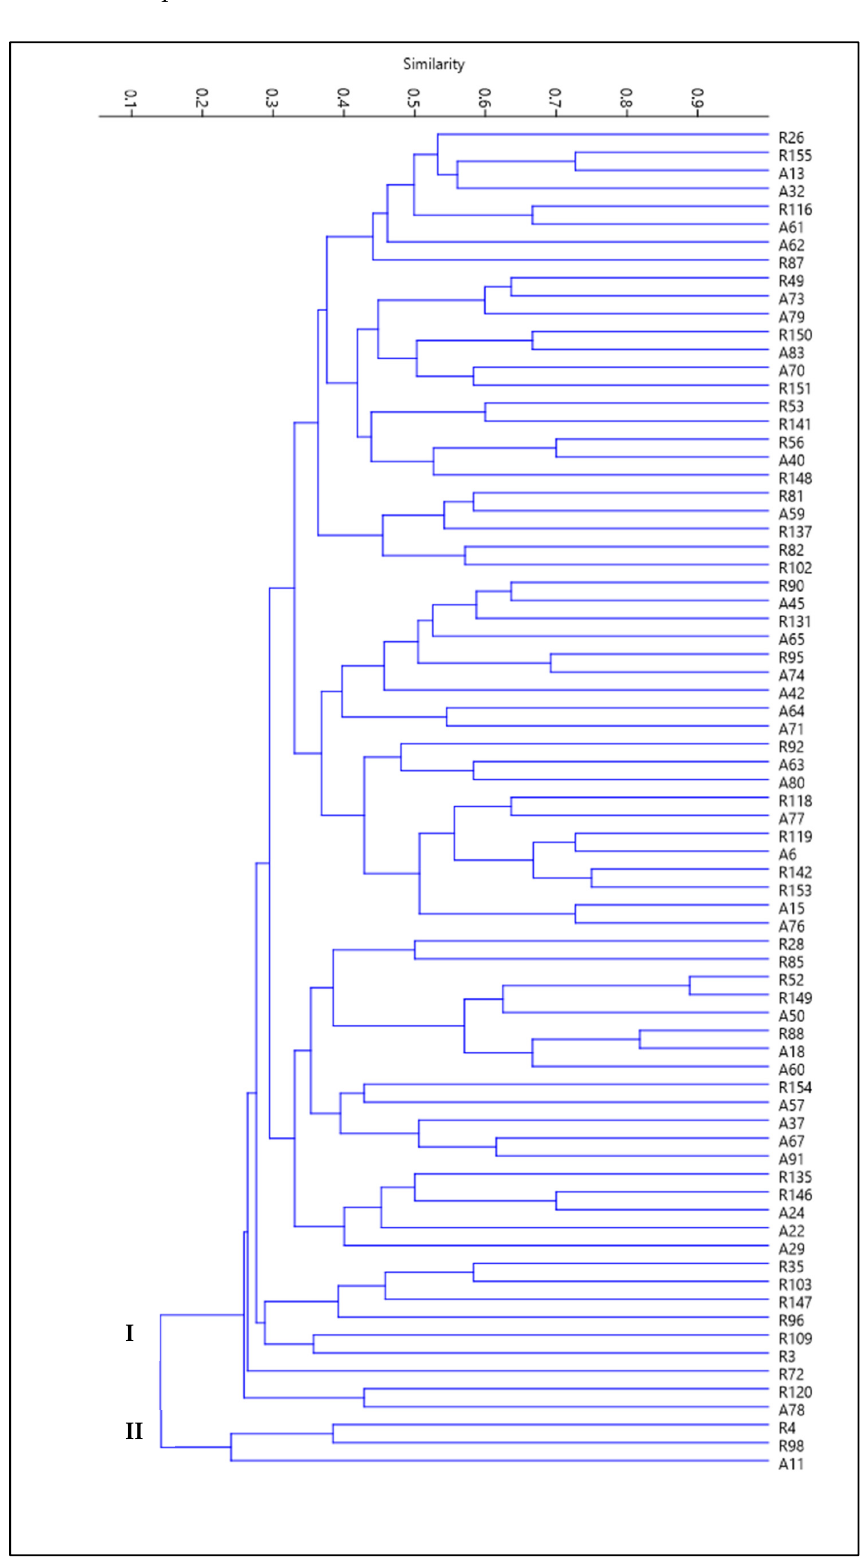
Figure 2. UPGMA cluster based on Jaccard for 34 big S. acuminata trees (A) and 41 small S. acuminata trees (R) in compartment 107, Kenaboi FR.